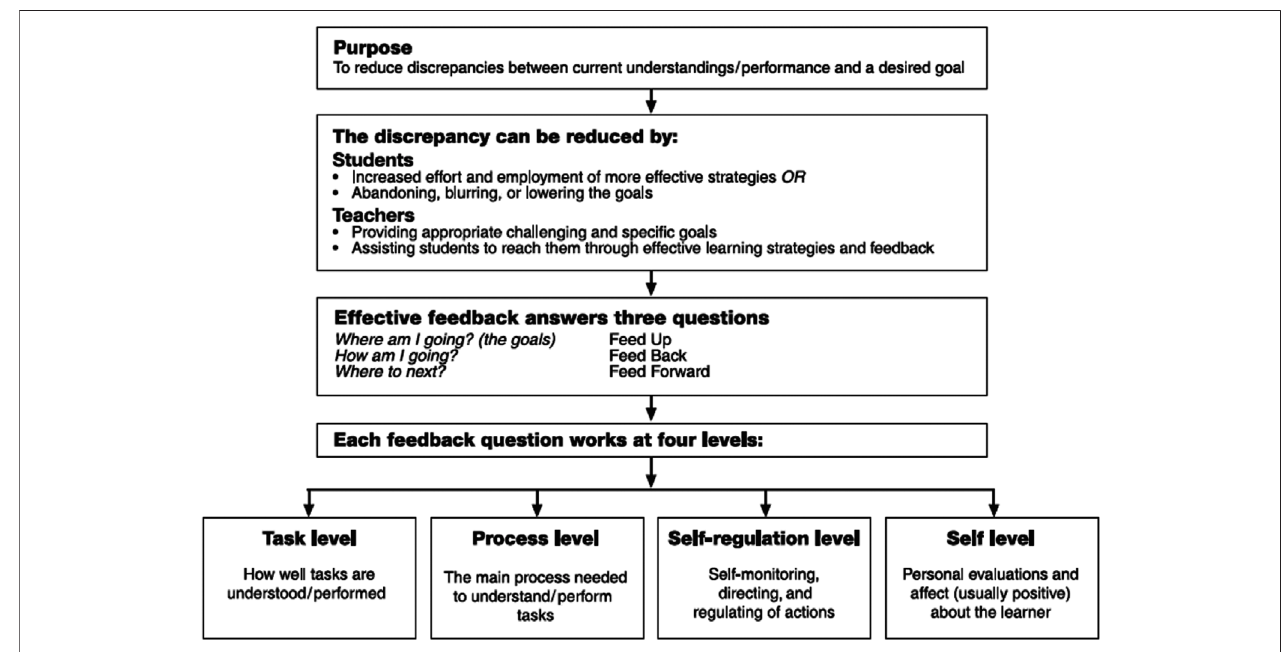
FIGURE 12 | Hattie and Timperley (2007) feedback